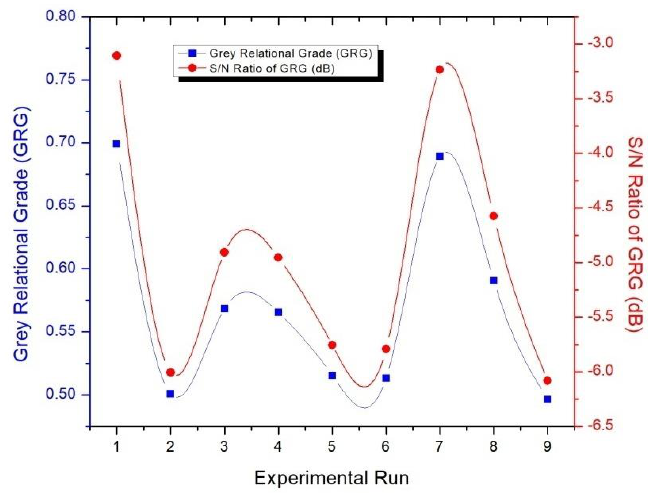
Figure 5. Plot of GRG vs S/N Ratios.